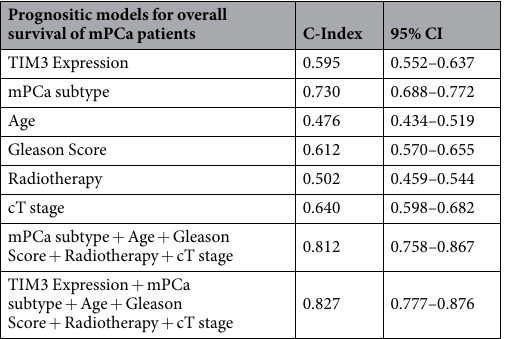
Table 3. Comparison of the accuracy of the prognostic models for overall survival.